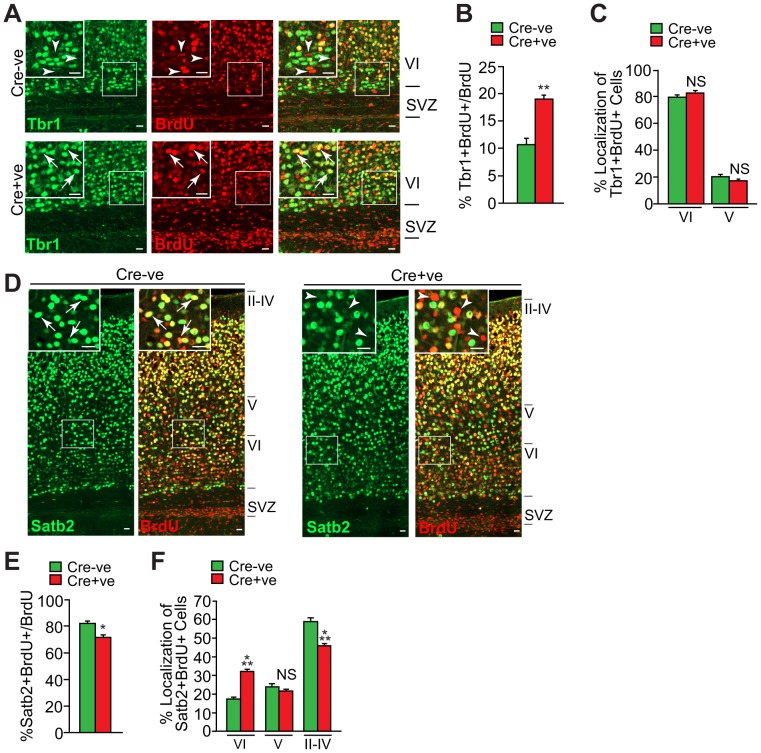
Postnatal deficits in cortical neurons in Snailfl/fl;nestin-cre mice.
Snailfl/fl mice that were positive (Cre+ve) or negative (Cre-ve) for the nestin-cre transgene were labelled with BrdU at E13 and their cortices were analyzed at P7. (A) Confocal micrographs of coronal sections through the SVZ and layer VI immunostained for BrdU (red) and Tbr1 (green; merges are shown on the right). The boxed areas are shown at higher magnification in the insets. Arrows denote double-labelled cells. Scale bar, 20 µm. (B) Quantification of sections as in A for the proportion of BrdU-positive cells that are also positive for Tbr1 (B) and their relative location within layers V and VI (C). (**p<0.01, n = 3 and 4 Snailfl/fl mice Cre+ve and Cre-ve, respectively). (D) Confocal micrographs of coronal sections through the cortex immunostained for BrdU (red) and Satb2 (green). The left panels of each pair show Satb2 alone, and the right panels the merges. The boxed areas are shown at higher magnification in the insets. The arrows denote double-labelled cells. Scale bar, 20 µm. (E,F) Quantification of sections as in D for the proportion of BrdU-positive cells that are also positive for Satb2 (E) and their relative location within the different cortical layers (F). (*p<0.05, ***p<0.001, n = 3 and 4 Snailfl/fl mice Cre+ve and Cre-ve, respectively).